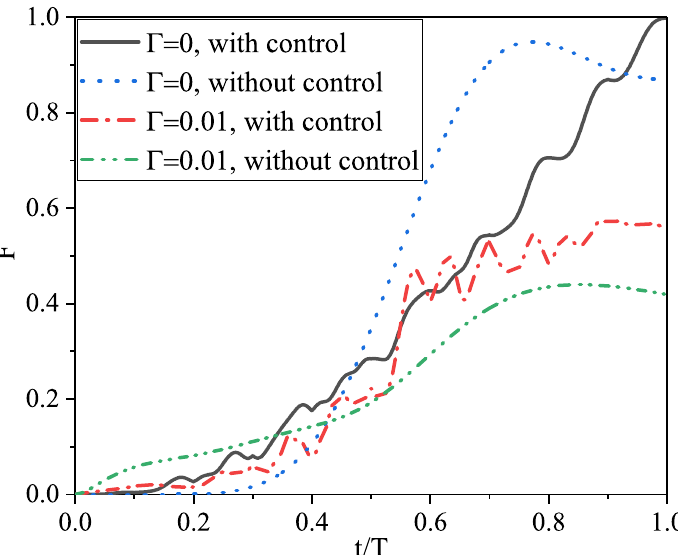
Figure 1. The fidelity F versus the rescaled time t / T . The total evolution time T = π . With control the parameters I = 20, τ = π /10. In the presence of an environment, the parameters are taken as Γ = 0.01, γ = 20, Tem = 20. The number of sites N =